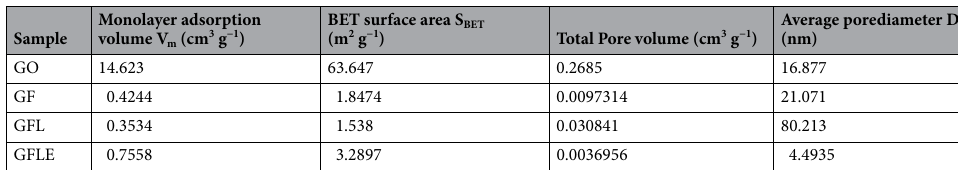
Table 3. BET experimental results of